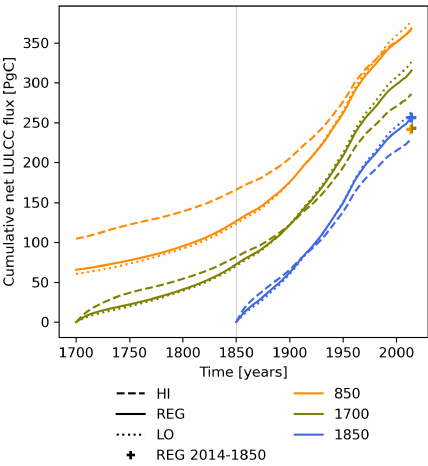
Figure 2. Global cumulative net LULCC flux since the start of the individual simulations. The flux in the land-use scenario HI, REG and LO (compare lines with same colour) and the relevance of start- ing date (compare same line style across colours) are shown. The three crosses in 2014 represent the total cumulative net LULCC flux of the three REG experiments (REG850, REG1700 and REG1850) if the flux is only calculated for the period 1850–2014. Note that the orange and green crosses overlap and are only partly visible.